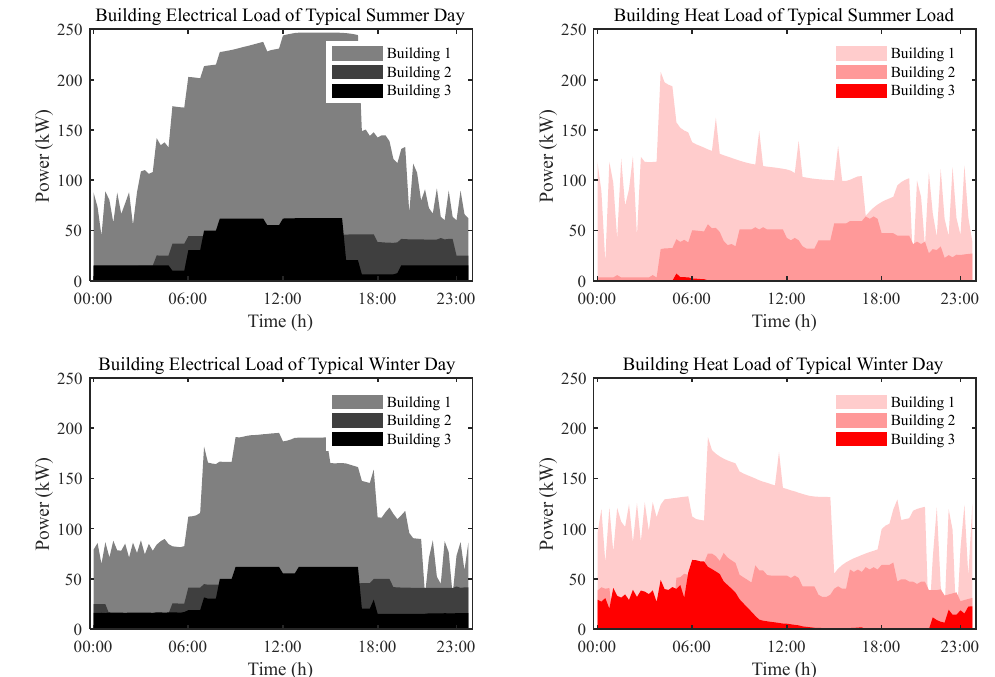
Figure A2. Building electricity/thermal load forecast curve for the case study.